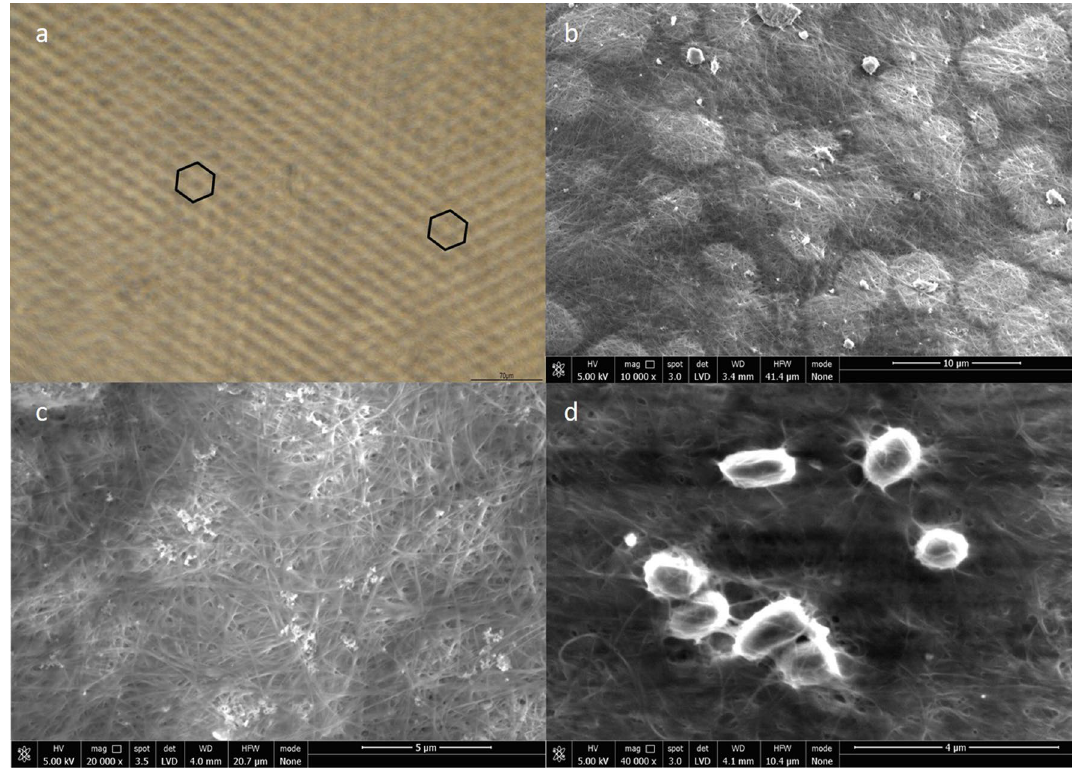
Figure 3. K2A8 strain as representative of the pool of strains. (a) Micro-pattern characterization. Hexagonal pattern of the surface-microstructured BC manufactured using biolithography. Hexagonal pattern-formation was observed by BF microscopy at high magnification ×20 using native BC. (b) SEM image of surface- microstructured BC. (c) SEM image of microstructured BC fibrous network. (d) SEM image of K2A8 present among microstructured BC fibrous